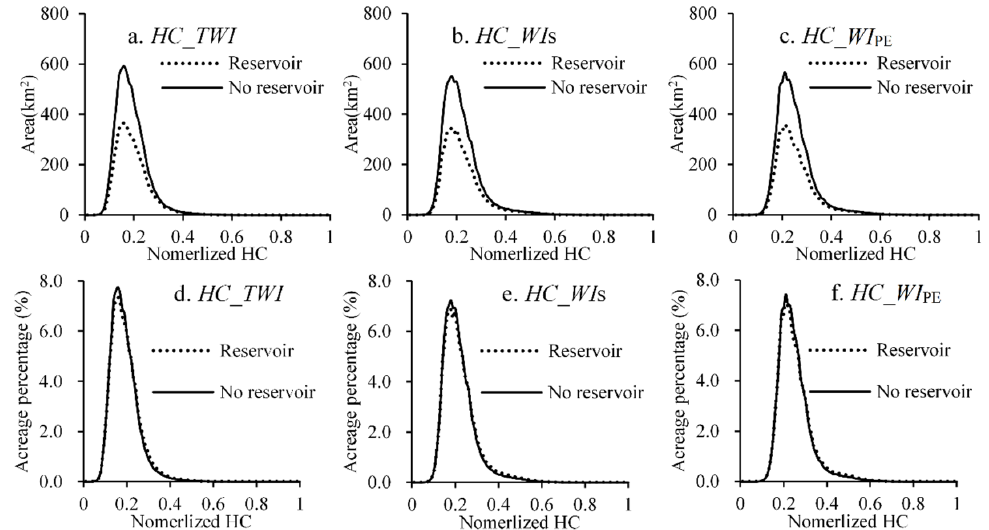
Figure 8. Acreage distribution of hydrological connectivity ( a , d ) HC_TWI , ( b , e ) HC_WI S , and ( c , f ) HC_WI PE in the ECA of the river before and after reservoir